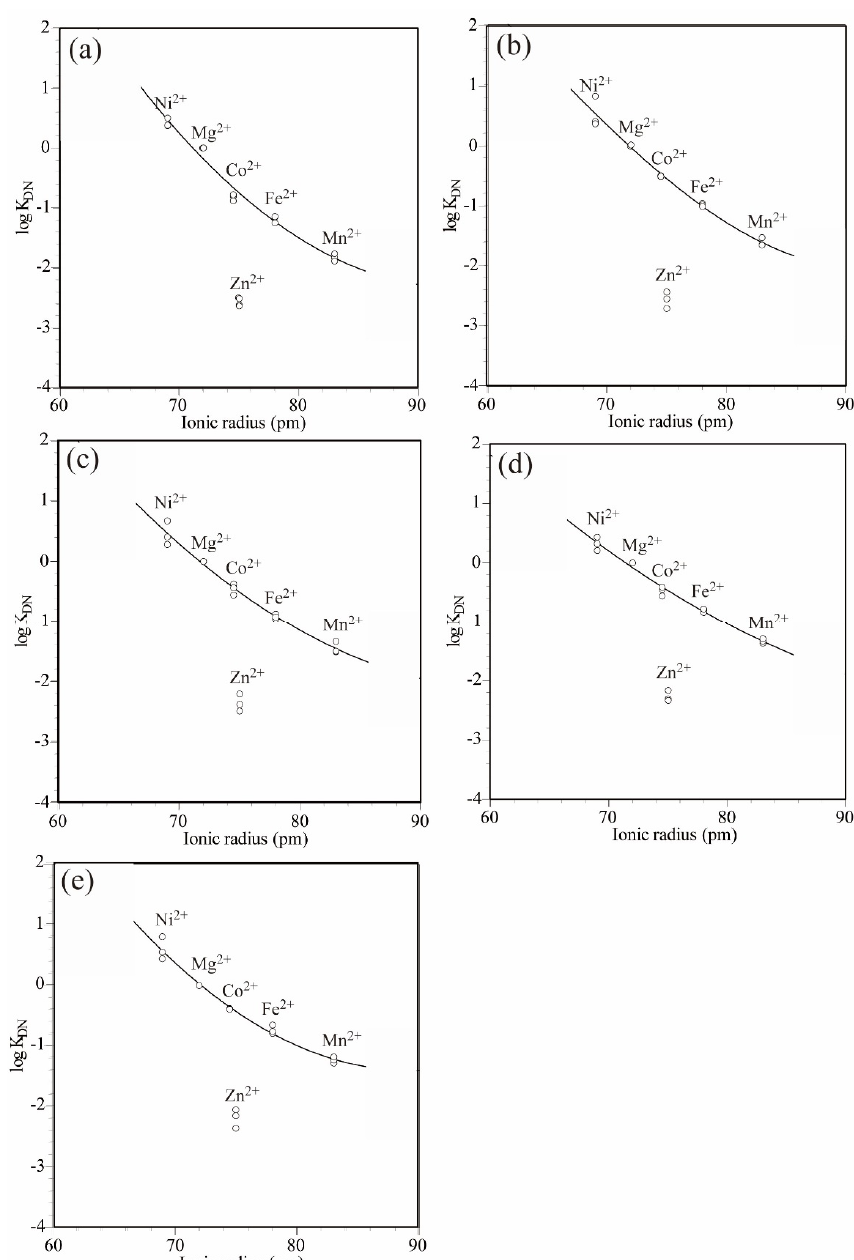
Figure 3. Logarithmic distribution coefficient (log K DN ) vs. ionic radius (PC–IR) diagrams for the olivine solid solution–(Ni, Mg, Co, Zn, Fe, Mn)Cl 2 –H 2 O system. PC–IR curves were obtained by the least-square method using a quadratic curve and assuming that Ni 2+ , Mg 2+ , Co 2+ , Fe 2+ , and Mn 2+ showed distribution behaviors based on their ionic radii. The solid starting material compositions were ( a ) Fo 100 , ( b ) Fo 75 Fa 25 , ( c ) Fo 50 Fa 50 , ( d ) Fo 25 Fa 75 , and ( e ) Fa 100